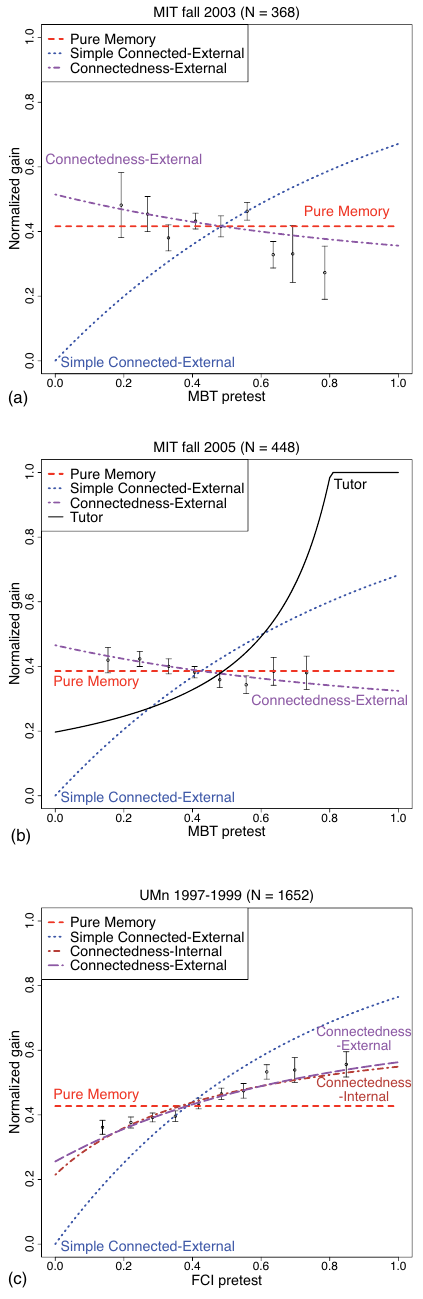
FIG. 2. (cid:1) Color (cid:2) Fits of pure memory, connectedness, and simple connected-external models to the normalized gain of (cid:1) A (cid:2) the MIT 2003 class, (cid:1) B (cid:2) MIT 2005 class, and (cid:1) C (cid:2) UMn 1997-1999 classes. The tutoring model is shown in (cid:1) B (cid:2) to illustrate its positive curva- ture in a normalized gain plot. For these plots, each data set was divided into bins of equal spacing except for two inclusive bins at the extremes of the pretest range (cid:1) hence the slightly wider separa- tion of the edge points (cid:2) , and the average and STD of the mean of the normalized gains of the students in each bin were plotted against their average pretest score. (cid:1) memory t instr and (cid:1) connted t instr were free parameters for the pure memory and the simple connected model fit. In the connectedness model fit, (cid:4) was determined by extrapolating between pure memory and the simple connected model. Results of fits are in Table